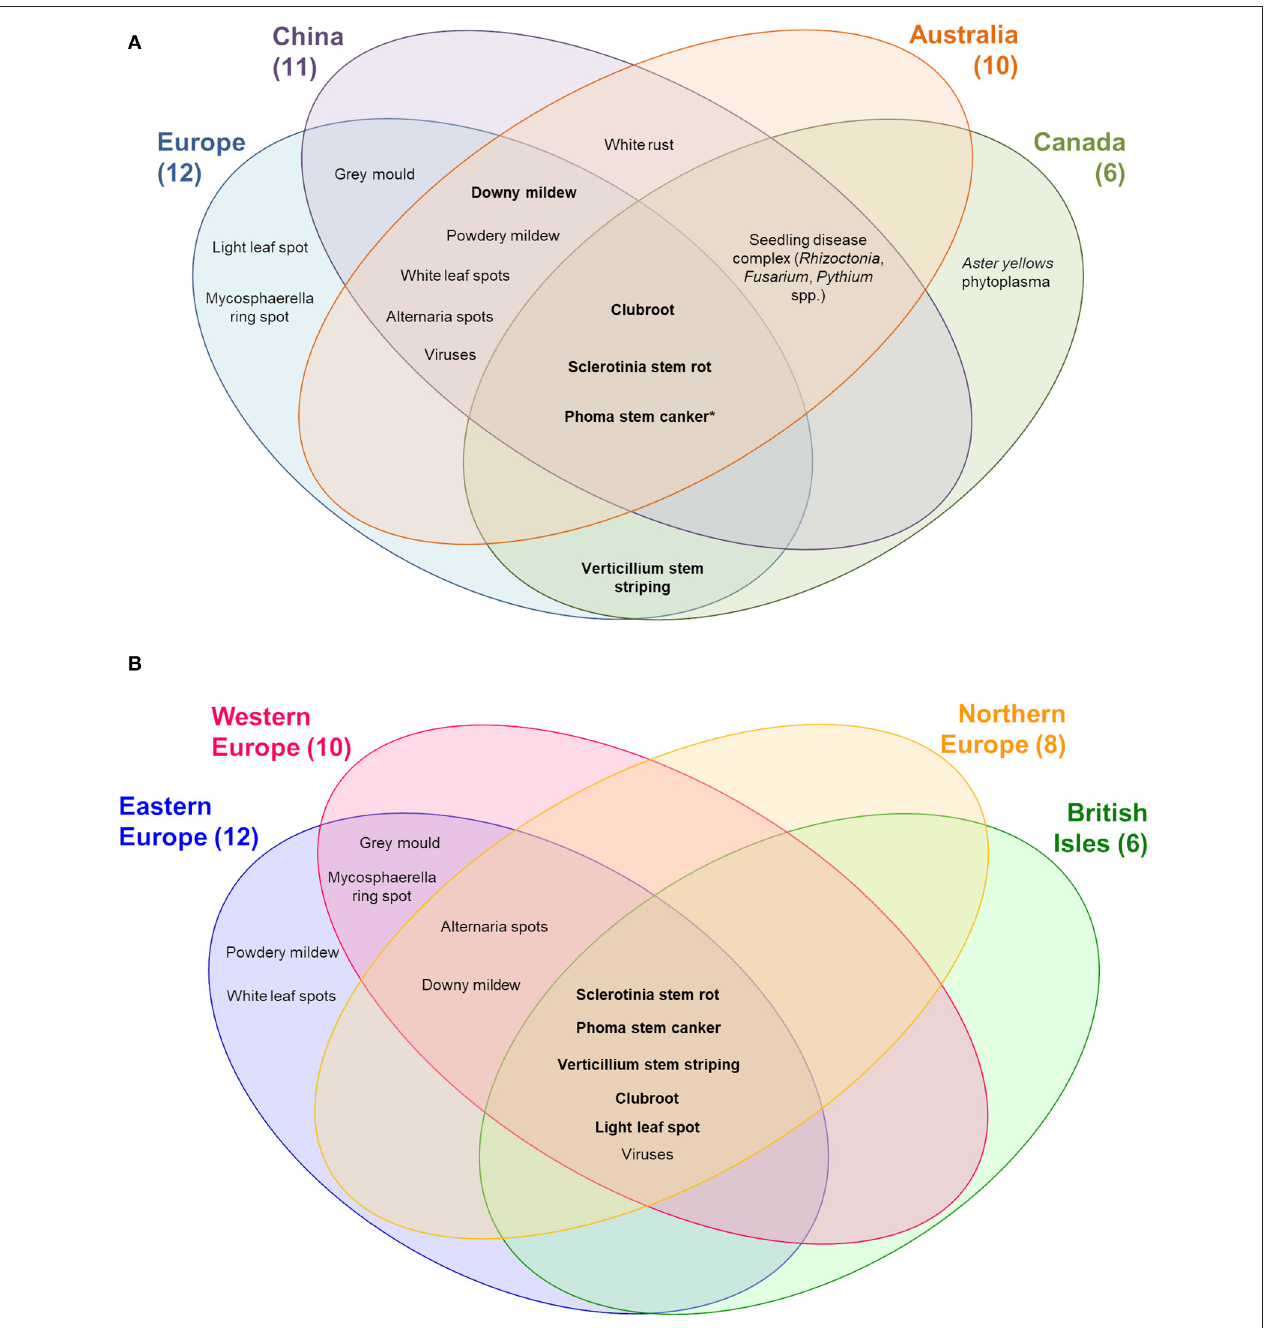
FIGURE 2 | Occurrence of important diseases on oilseed rape worldwide (A) and in Europe (B) . Top 10 diseases worldwide are marked in bold letters. *In China only Leptosphaeria biglobosa but not L. maculans has been reported.